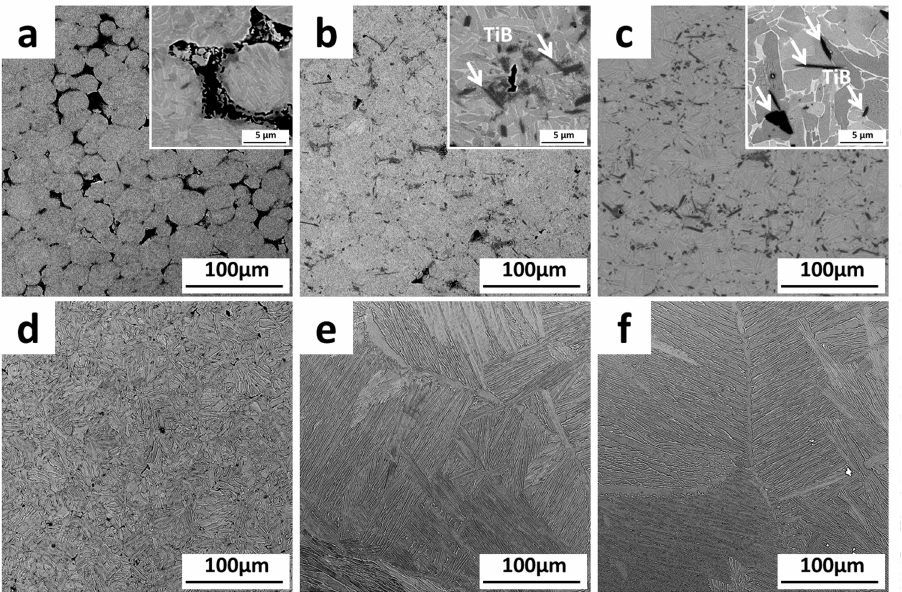
Figure 6. The microstructures of TMCs with A-B addition sintered at different temperatures: ( a ) 900 ◦ C;